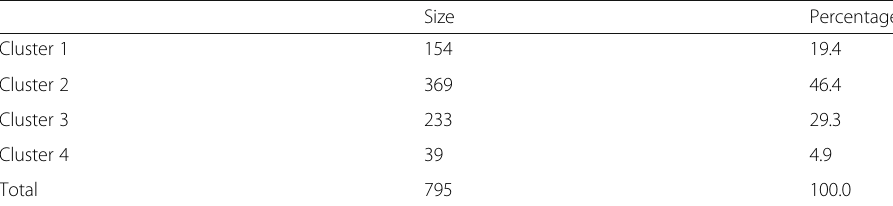
Table 5 Cluster sizes